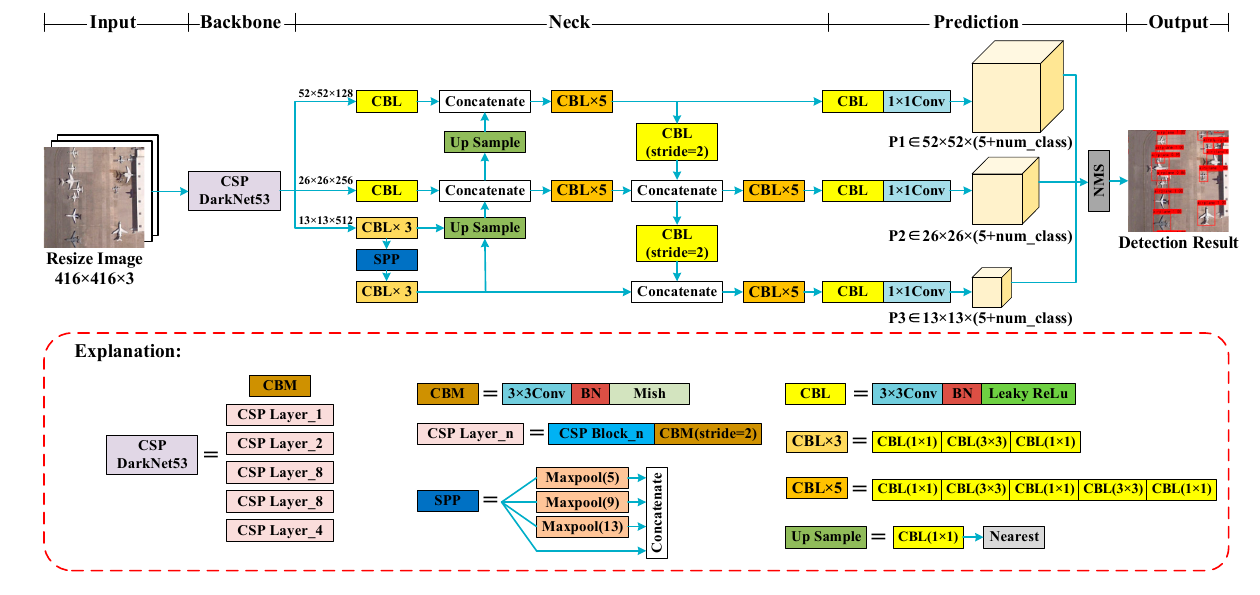
Figure 2. The architecture of YOLOv4.